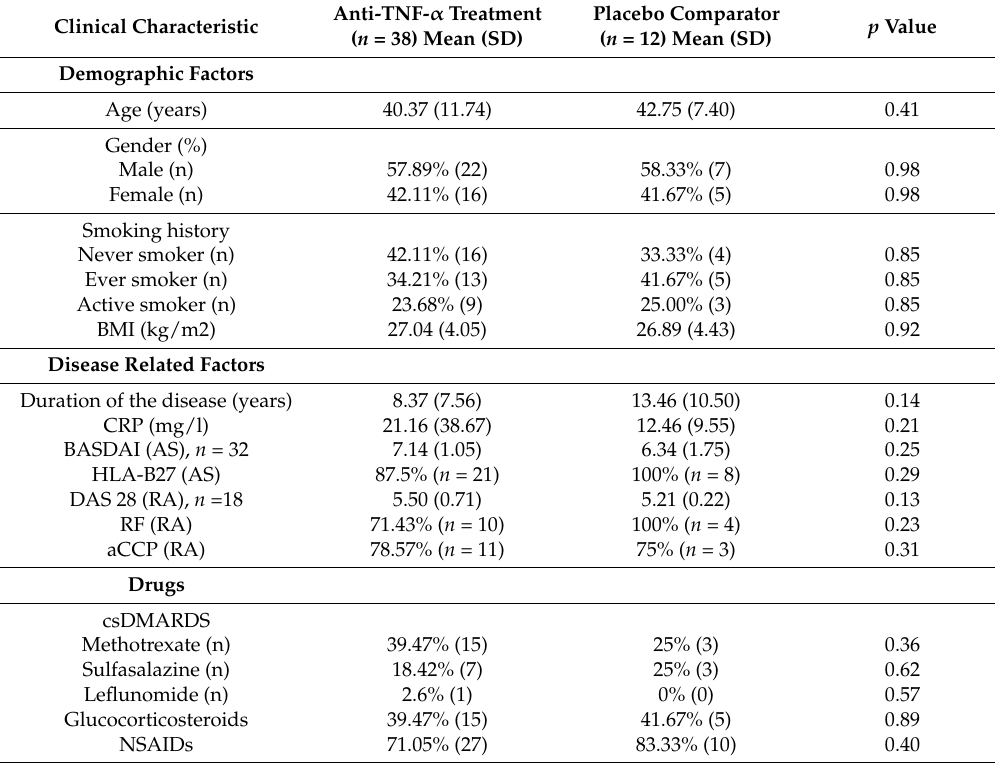
Table 1. Baseline clinical and biochemical characteristics of rheumatoid arthritis (RA) and ankylosing spondylitis (AS)